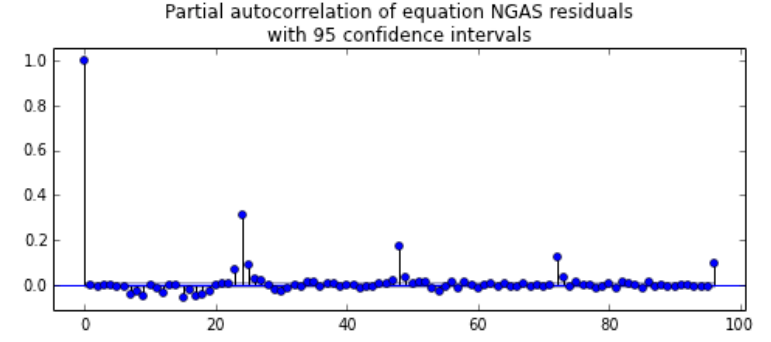
Figure A3. Density plot for wind power capacity factor for Greece. Figure A4. LOLP as a function of the Greek system load.